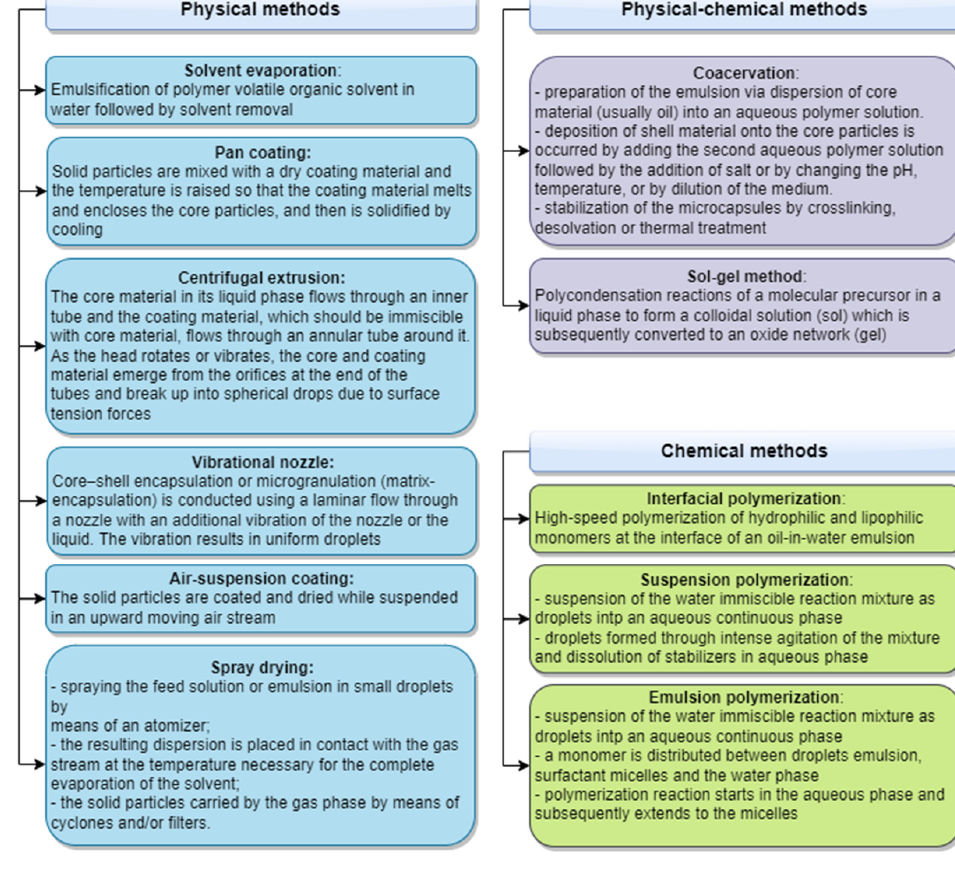
Figure 5. Microencapsulation methods [112].